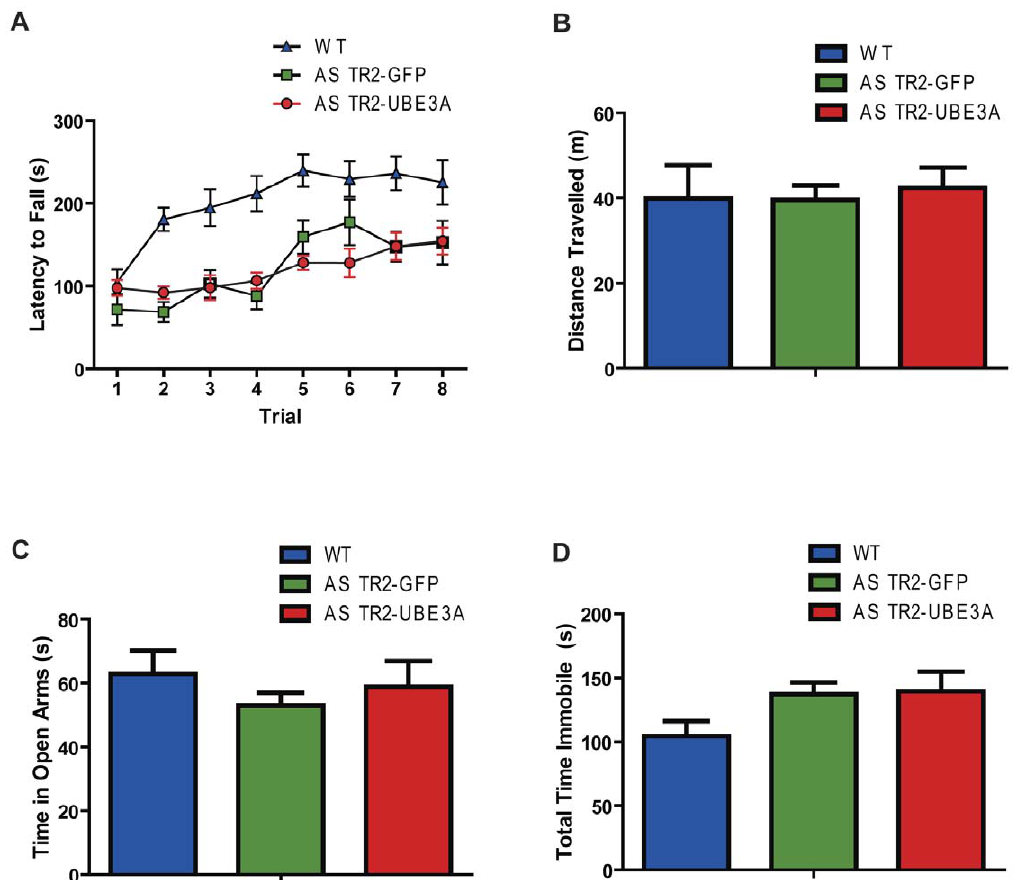
Figure 3. There were no changes in motor coordination, activity levels, or anxiety. (A) There was no change in latency to fall of the rotorod in either AS group. (B) Total distance travelled during the open field test revealed no significant difference between any of the treatment groups. (C) Time spent in the open arms of the elevated plus maze was used to determine general anxiety. (D) Time spent immobile in the elevated plus maze was not significantly different in any of the groups. Results shown represent the mean with standard error.